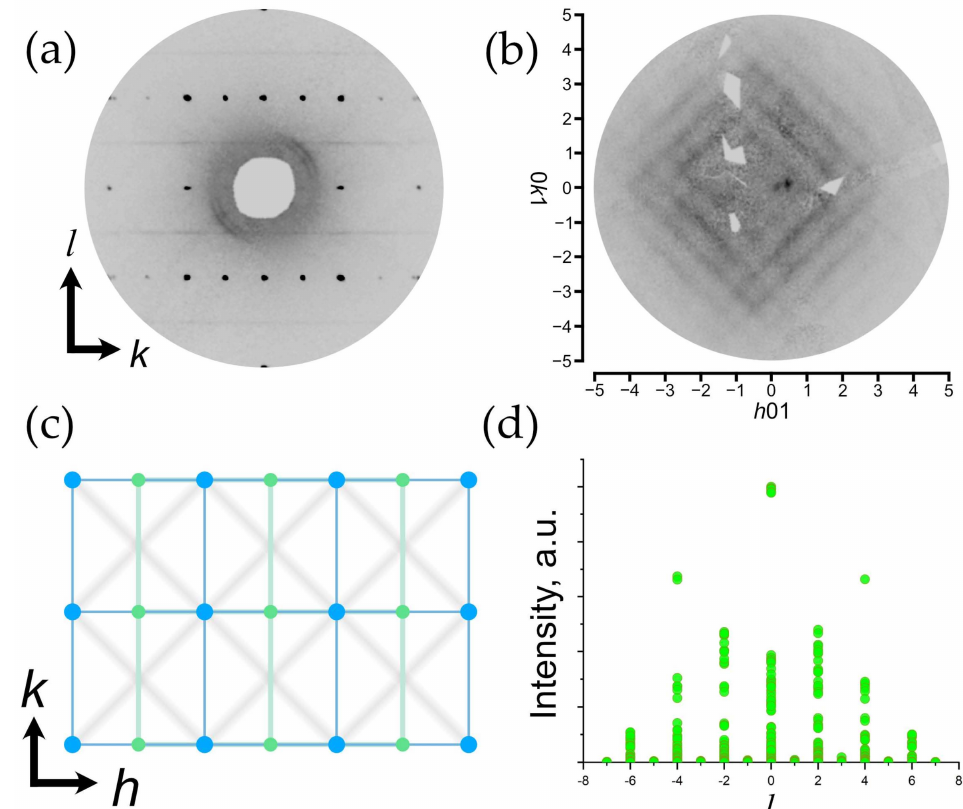
Figure 4. A precession image of the 0 kl reciprocal lattice plane in orthorhombic setting ( a ); a precession image of the hk 1 reciprocal lattice plane in monoclinic setting ( b ); a relationship between hypothetical Bragg reflections of orthorhombic (green) and monoclinic (blue) lattices overlapping diffuse scattering (gray) ( c ); a distribution of reflection intensity plotted vs. l values ( d ). Note: for ( b ), a background subtraction was applied with the minimum value set as